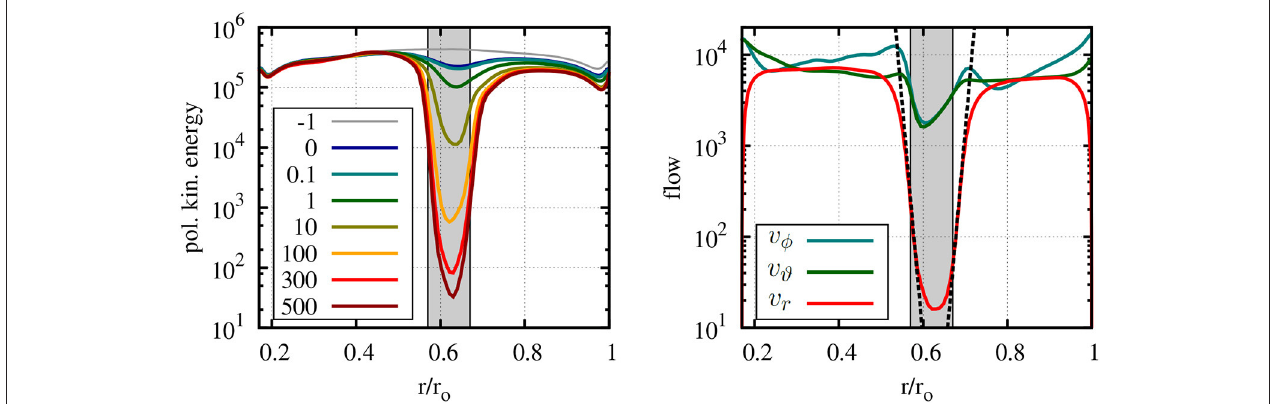
FIGURE 3 | Time averaged radial profiles of the non-axisymmetric poloidal energy for various stratification strength A SSL (Left) and horizontally averaged intensity of non-axisymmetric flow components v r , v φ , v ϑ for model 1.2 with A SSL 300 (Right) . The dashed lines denote the assumed exponential decay =